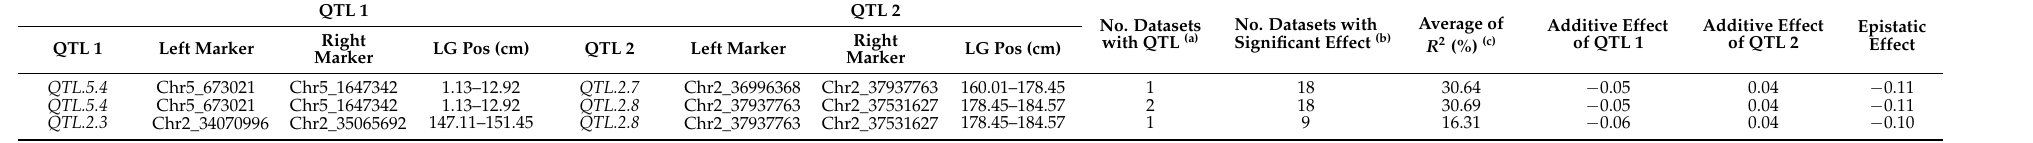
Table 4. Quantitative trait loci (QTL) detected using the additive-epistatic model